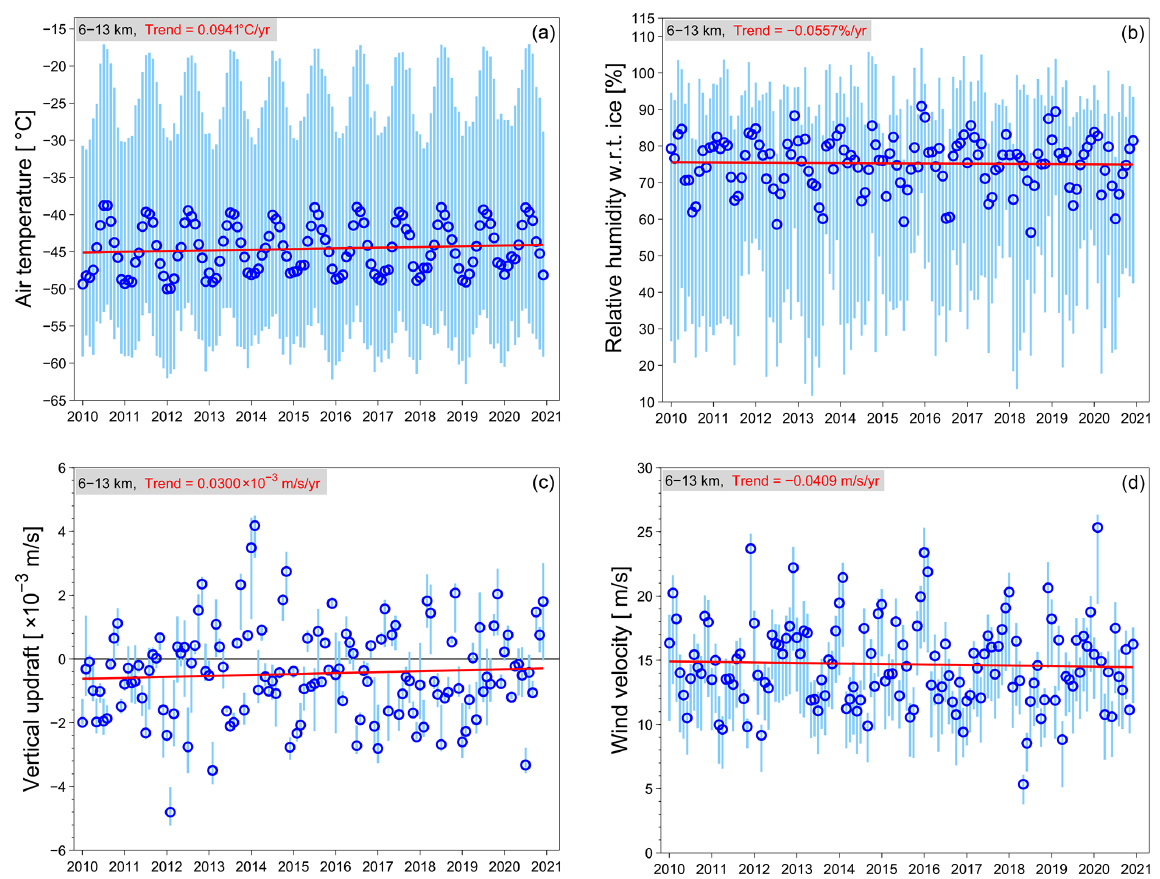
Figure 2. Monthly variations in air temperature, relative humidity with respect to ice (RHi), vertical updraft, and wind velocity in the background at altitudes from 6 to 13km, derived from ERA5 reanalysis data for 11 years from 2010 to 2020 over the European area (i.e. the research area in this study, lat: 35–60 ◦ N, long: 15 ◦ W to 15 ◦ E). The vertical bars show the value ranges for temperatures and RHi, respectively, in panels (a) and (b) , and for vertical updraft and wind, respectively, in panels (c) and (d) . The blue circles show the medians of each quantity in different months and the red lines are the best-fitting lines using the simple linear regression to data for all of them.